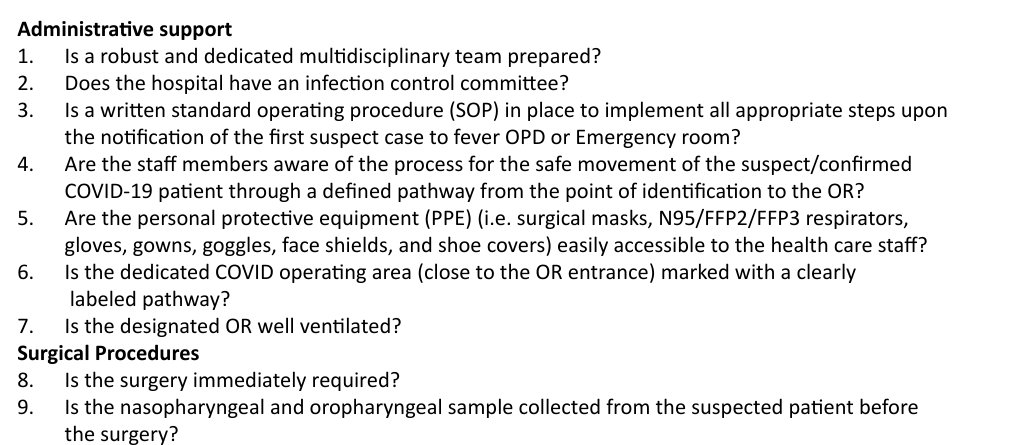
table 1. Highlights the important points to be considered for preparedness for a surgery during the COVID-19 pandemic